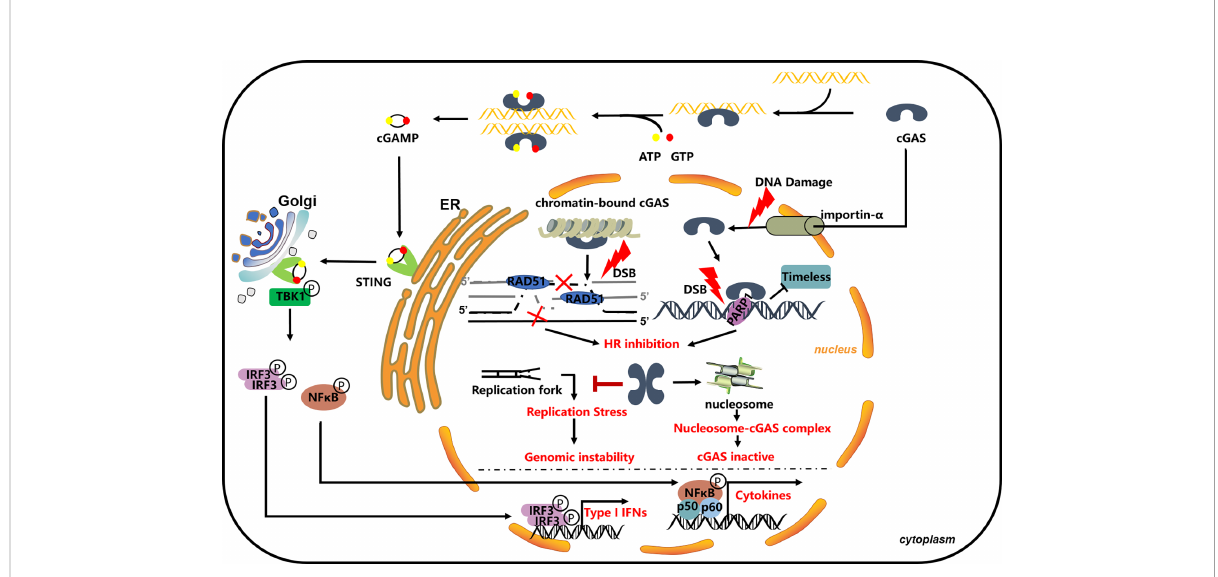
FIGURE 1 cGAS in DNA damage repair process. cGAS impaired the HR process through bind to chromatin and promoting its compaction, blocking the invasion of RAD51 and following the HR process (60); cGAS directly interacts with PARP1 and blocks its interaction with Timeless; the thought that it can be modi fi ed by PARP1 in the nucleus is unclear (63); cGAS can bind to the replication fork and slow down the replication progress and participate in replication stress-induced DNA repair